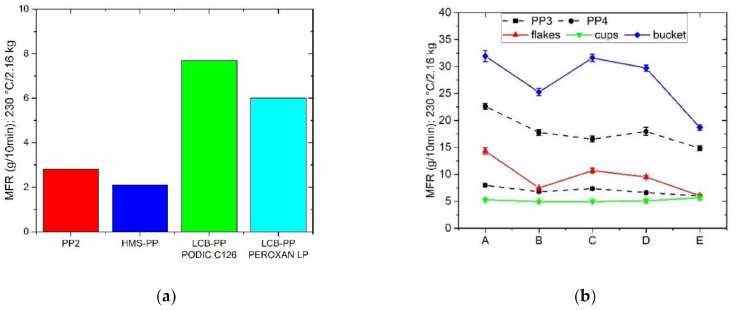
Figure 2. Melt flow rate (MFR) values of the materials, which was used for blending ( a ) as well as all starting materials and their blend series ( b ); measured at 230 ◦ C with 2.16